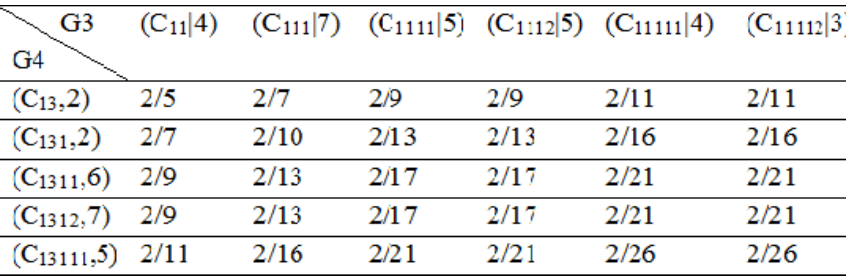
Table 2. Similarity between the concepts of graphs G3 and